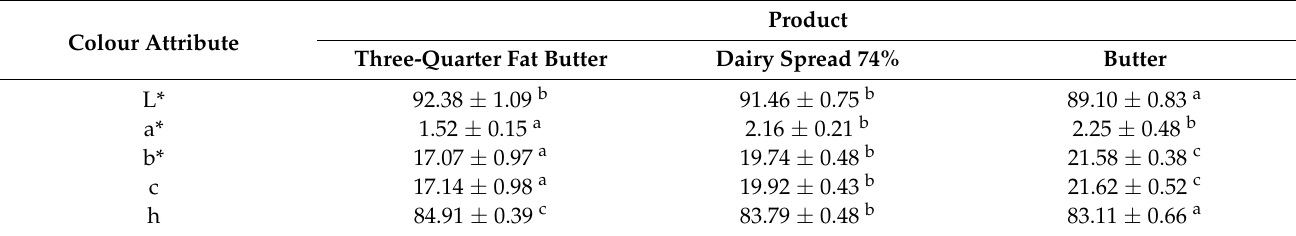
Table 2. Colour attributes of the analysed